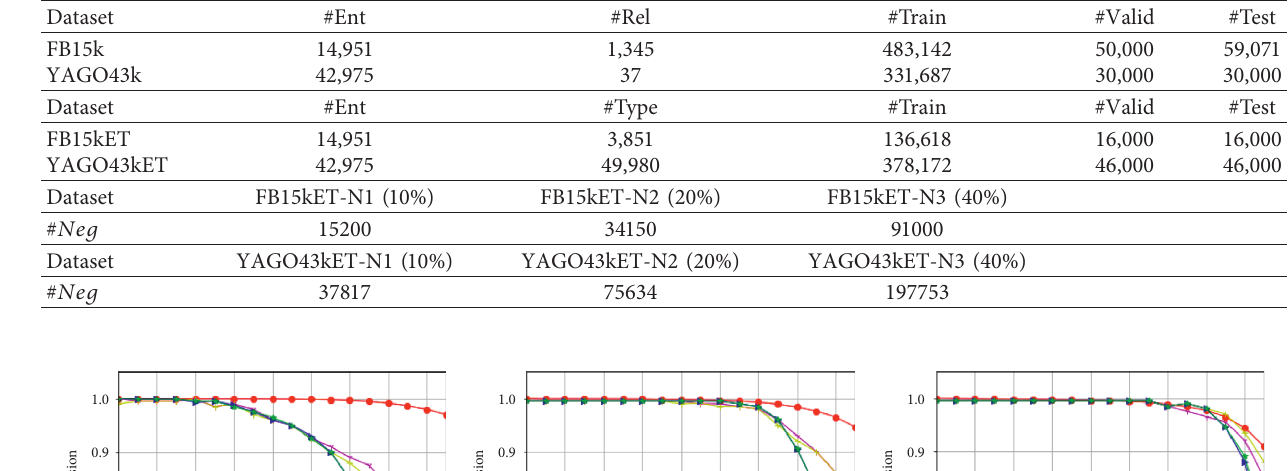
Table 2: Statistics of datasets.